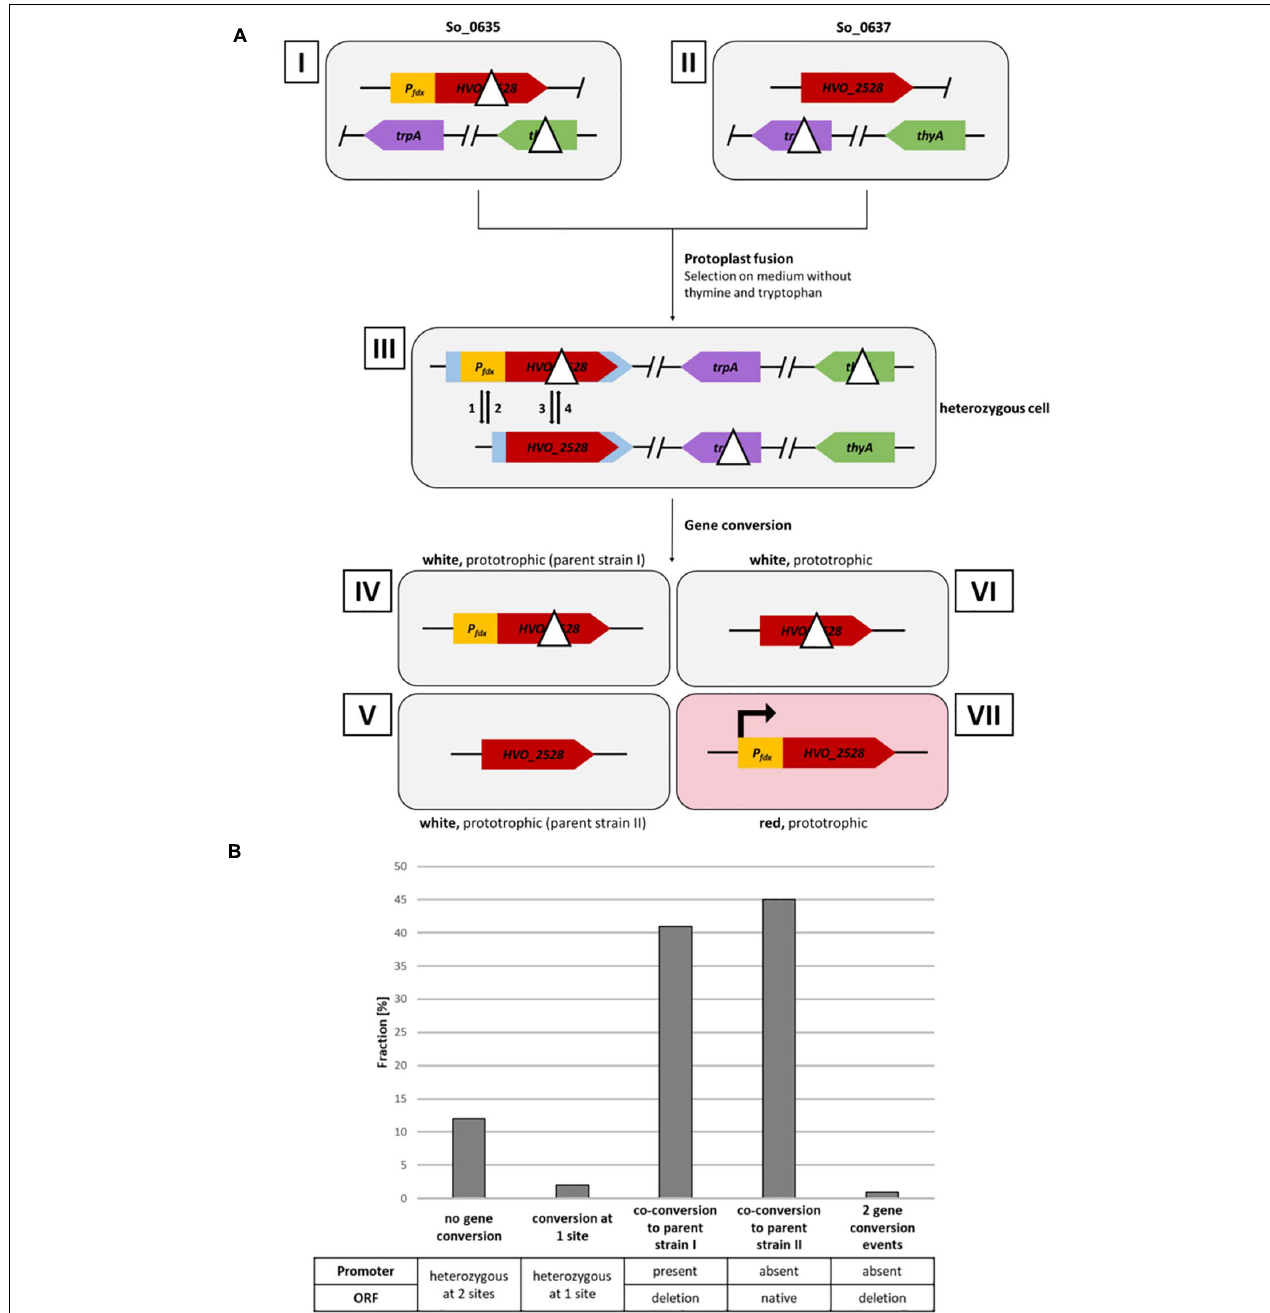
FIGURE 2 | Analysis of gene conversion at two sites with a distance of 626 bp. (A) Schematic overview of a gene conversion experiment. Roman numbers indicate the involved input and output strains. Strains I and II are homozygous parent strains, which are fused by protoplast fusion to generate the heterozygous strain III. Strains IV–VII indicate the possible output strains in the absence and presence, respectively, of gene conversion. The Arabic numbers 1–4 indicate possible gene conversion events at the two relevant genomic sites. Gene conversion at the two selection genes thyA and trpA have been omitted. (B) Results of the gene conversion experiment. 130 white clones were analyzed by PCR with primers specific for the two sites of possible gene conversion. The fractions (%) of clones are shown that experienced gene conversion at none, one or two of the sites. One biological replicate was performed.